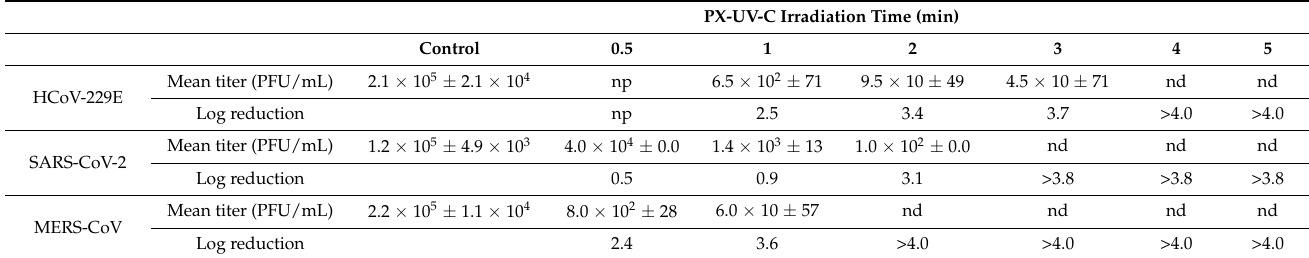
Table 1. Efficacy of PX-UV light in reducing human coronavirus titers on plastic surfaces at a 1.5 m distance. PX-UV-C Irradiation Time (min) Control 0.5 1 2 3 4